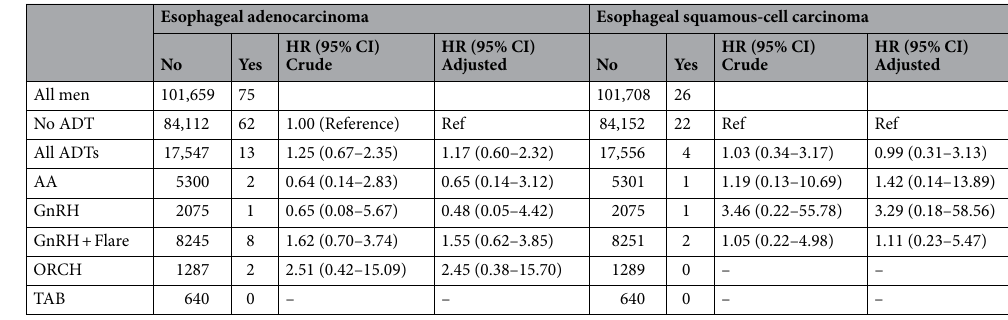
Table 2. Multivariable analysis of hazard ratio (HR) with 95% confidence interval (CI) of esophageal adenocarcinoma and esophageal squamous-cell carcinoma according to exposure to androgen deprivation therapy (ADT). Multivariable Cox proportional hazard model including marital status (not married, married, separated and widower) and educational level; low (less than 10 years), intermediate (10–12 years) and high educational level (> 12 years). AA anti-androgens, GnRH gonadotropin releasing hormone, GnRH + Flare gonadotropin releasing hormone + flare protection with AA for a limited time (usually a month),